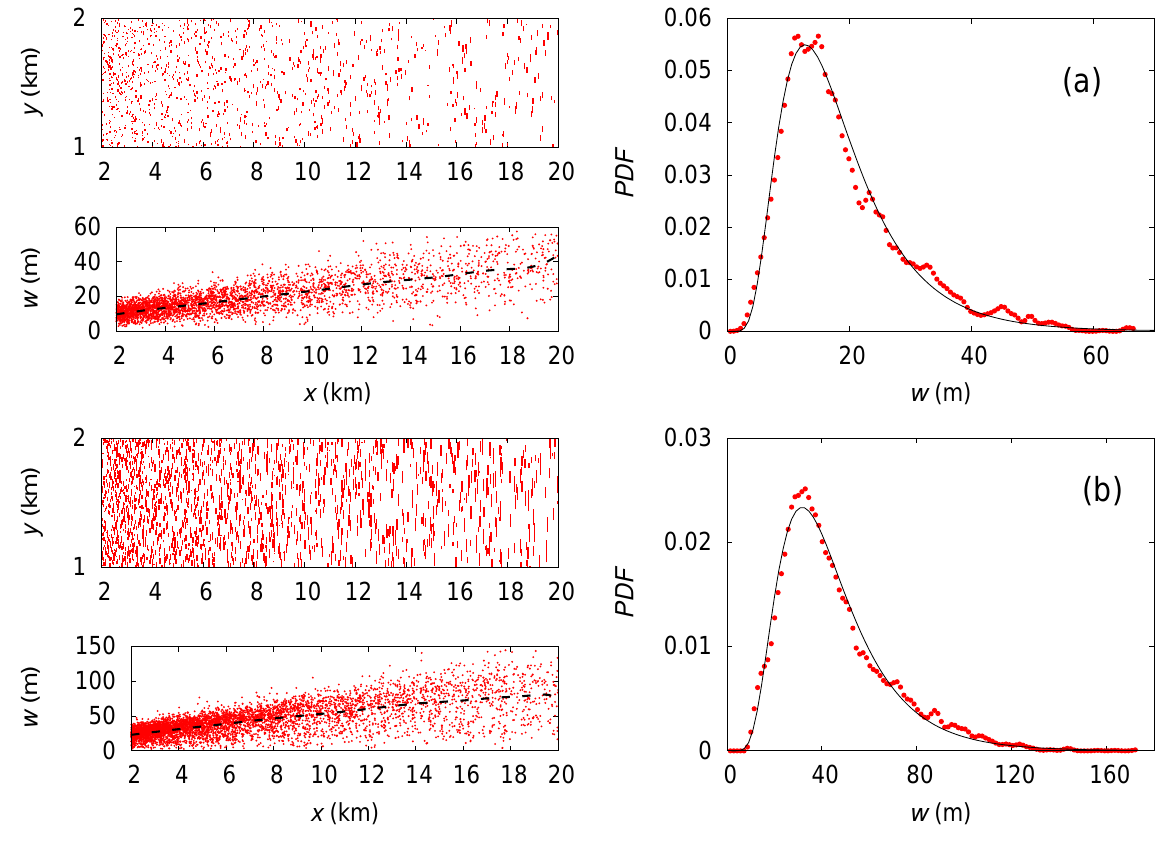
Fig. 10. Dune width distribution of two simulated dune fields with different mean size and density: (a) w 0 = 10m, ρ 0 = 0 . 18, and (b) w 0 = 20m, ρ 0 = 0 . 42, together with a snap shot of the field in the stationary state (top left) and the downwind dune size distribution (bottom left). In the distribution function, dots are measured points and the line is the analytical model. Empirical dune size distribution of real dune fields have size distributions with the same shape, and were described in Duran et al.